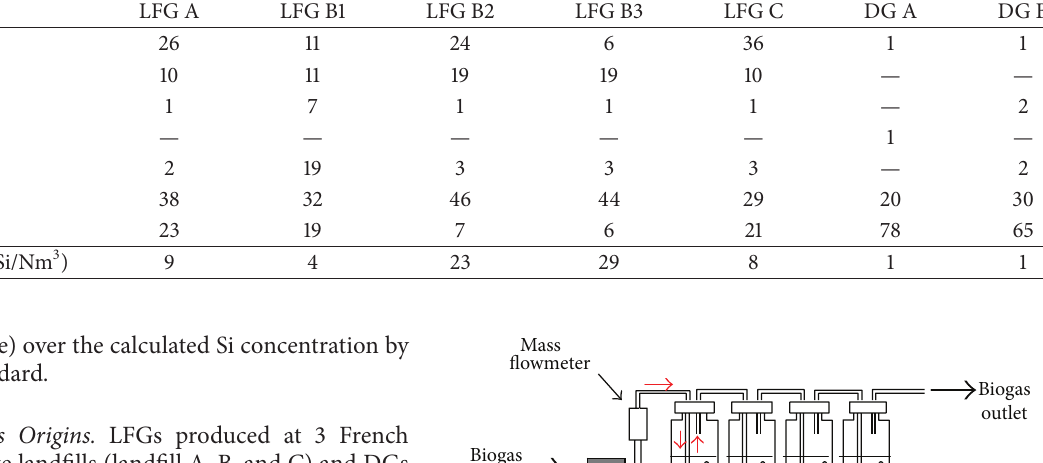
Table 1: Typical LFGs and DGs compositions in % of Si for each VOSiC by GC-MS and the total Si in mgSi/Nm 3 biogas. % Si